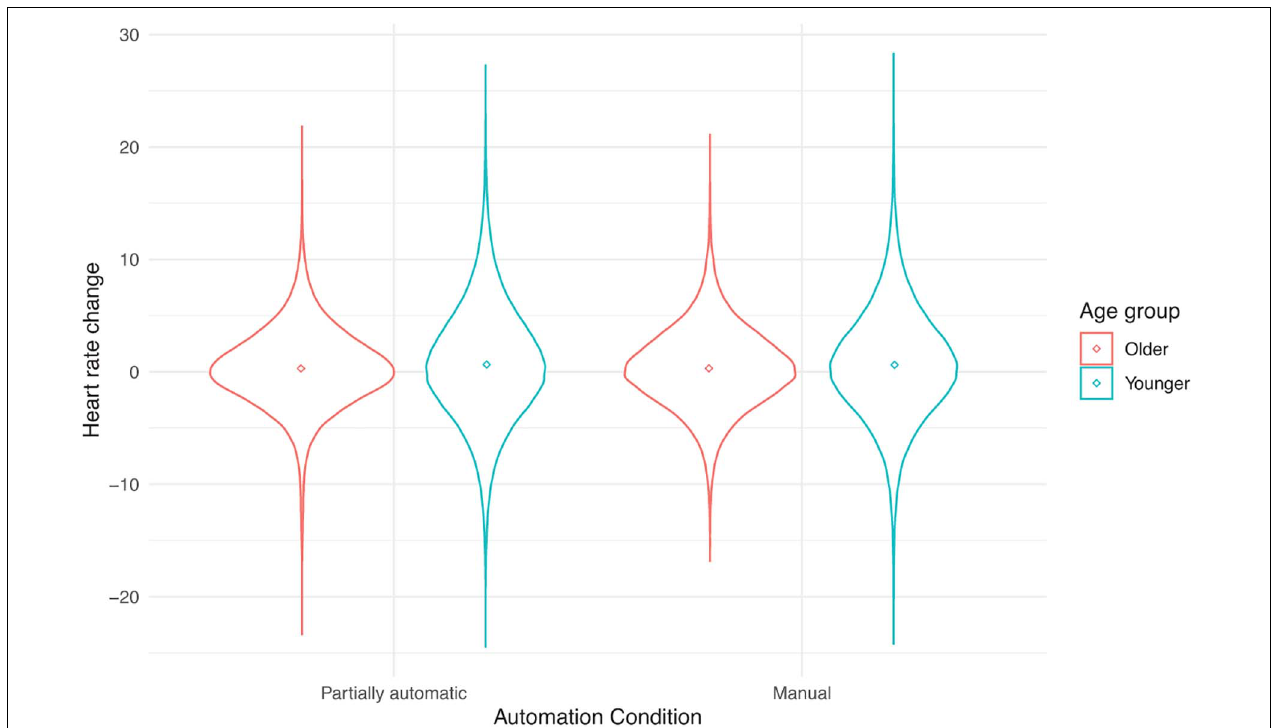
FIGURE 1 | Heart rate change from baseline as a function of automation (manual and partial automation) and age (younger or older).